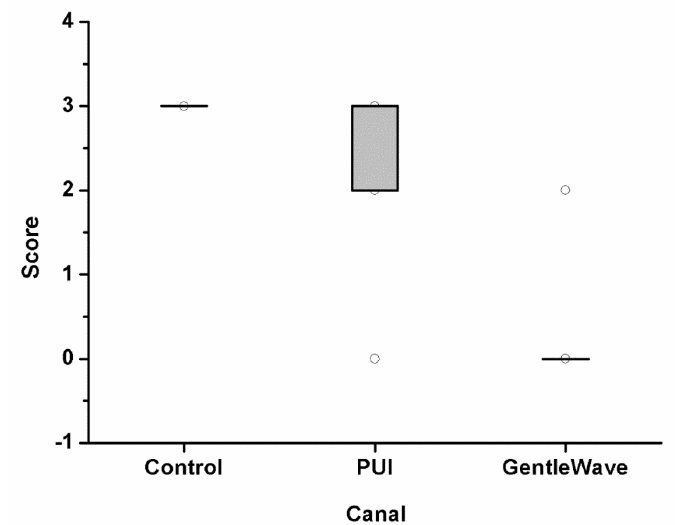
Figure 3. The level of biofilm attachment scores from three independent evaluators for 39 molars in the main canal (middle) region. The samples were either untreated (Group 1), treated with passive ultrasonic activation system (Group 2), or treated with the GentleWave system (Group 3). The modified scores utilized were—Score 0: no bacteria; Score 1: sparse and detached bacteria; Score 2: well defined biofilm (small colonies, <50% of the canal wall covered); and Score 3: well defined biofilm (large colonies, >50% of the canal wall covered). The average scores analyzed for the canals between Group 2 and Group 3 were statistically different ( p < 0.001).